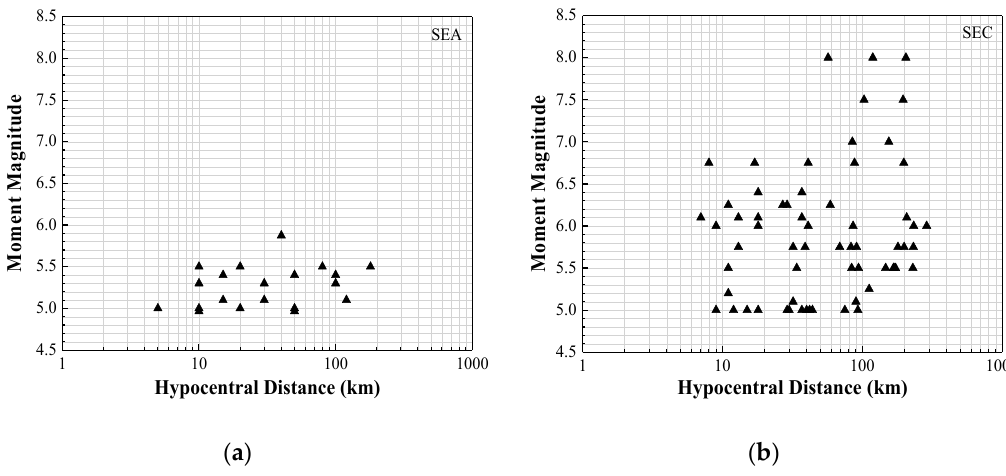
Figure 1. M-R combinations for selected regions. ( a ) South-Eastern Australia (SEA); ( b ) South-Eastern China (SEC).